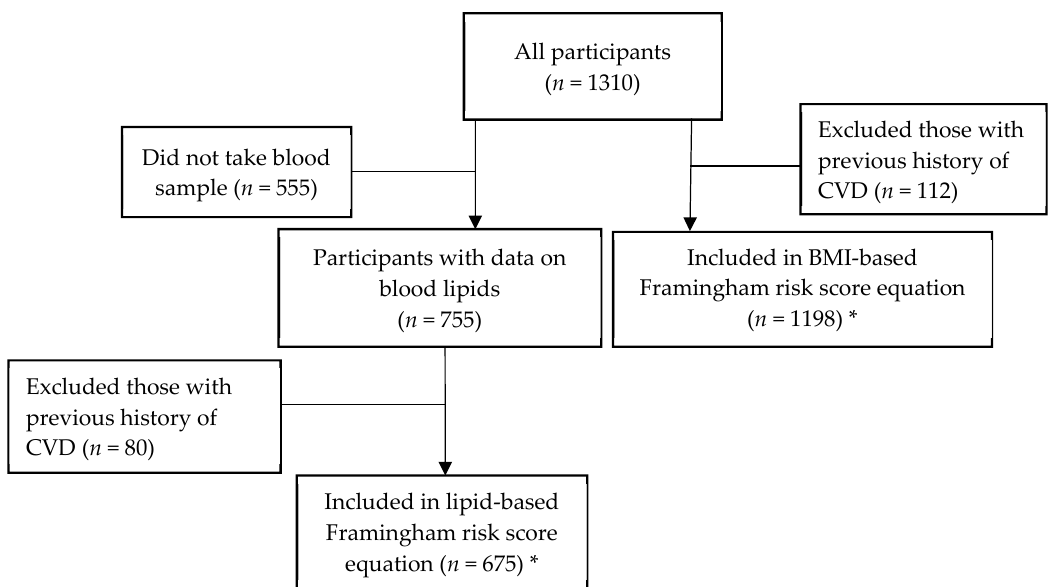
Figure 3. Flow chart illustrating participants included in the different analyses. * n is different between those who were included in the lipid-and BMI-based Framingham risk score equations due to missing data from lab results in the lipid-based analyses.